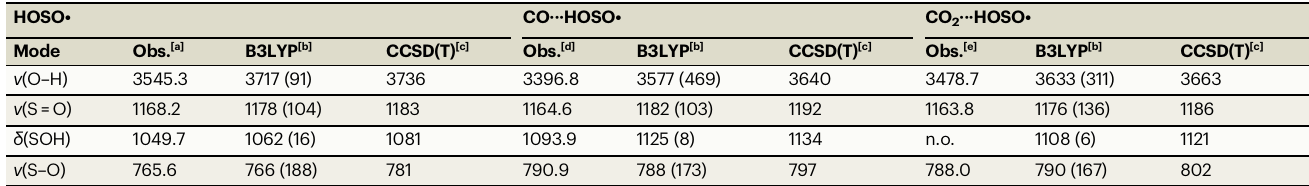
Table 1 | Calculated and observed Infrared (IR) spectra of HOSO (cid:129) in different matrixes HOSO (cid:129) CO ··· HOSO